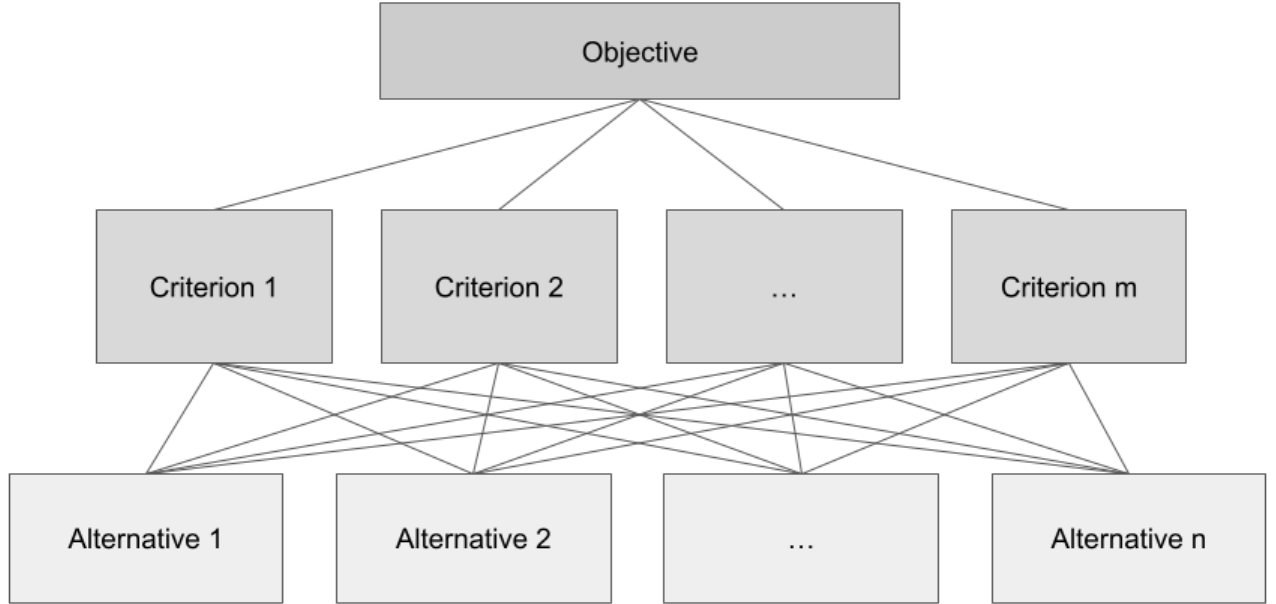
Figure 1. Representation of the basic hierarchical structure of the AHP method. Source: adapted from [37].